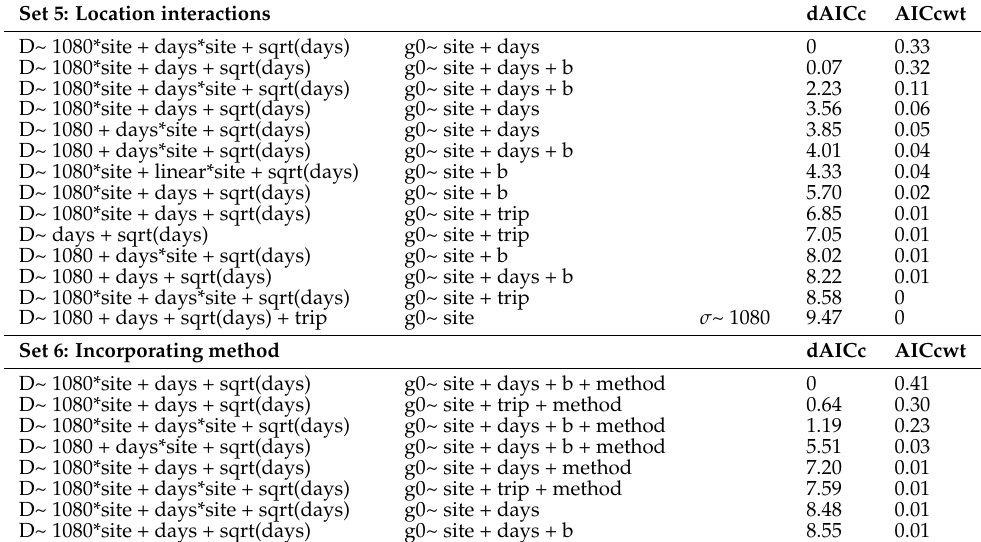
Table 4. Summary of model Set 5 and 6 (all models with dAICc <